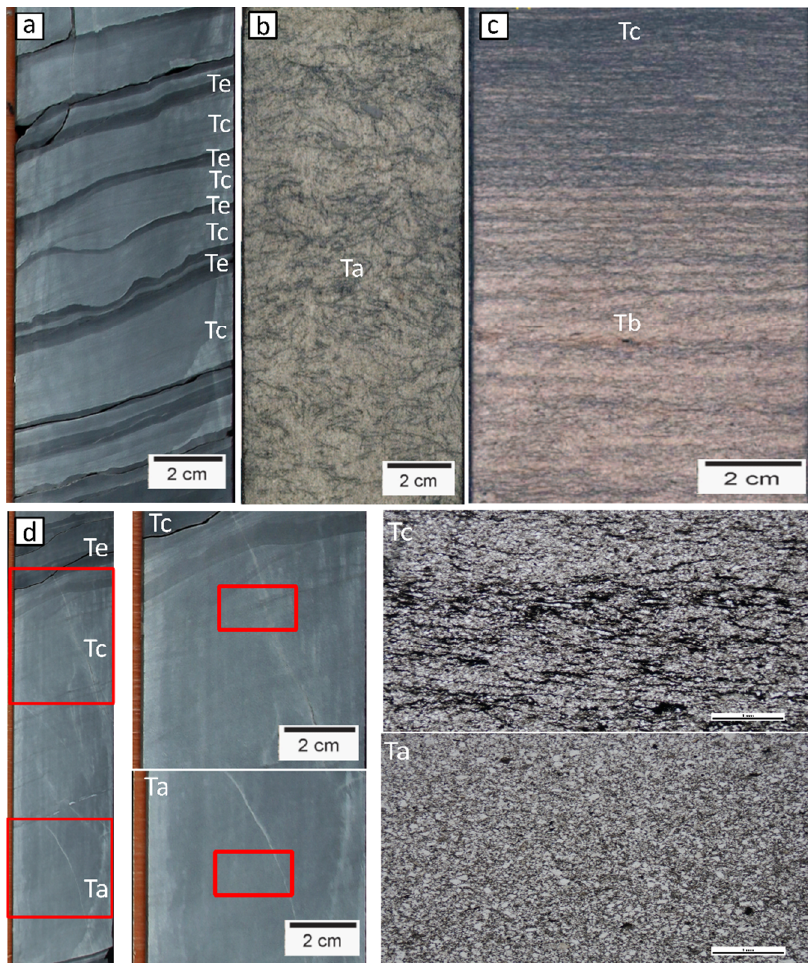
Figure 3. Core photographs showing ( a ) a stack of low-density turbidites with efficient segregation of sand and mud components in the Ross Sandstone Formation, western Ireland; ( b , c ) organic-rich Ta ( b ) and Tb-Tc ( c ) divisions in sandy turbidites from the Miocene deep-water succession of Kutei Basin, Indonesia [1]. Reprinted/adapted with permission from Ref. [1], 2006, AAPG; and ( d ) organic-lean sandy Ta and Tc divisions in a turbidite from the Ross Sandstone Formation, western Ireland. In ripple-laminated sandstones, mud chips and minor OM is occasionally fractionated in the lee side of the ripples, as seen in the photomicrograph Tc. Red rectangles on the core photographs show the location of plug samples.